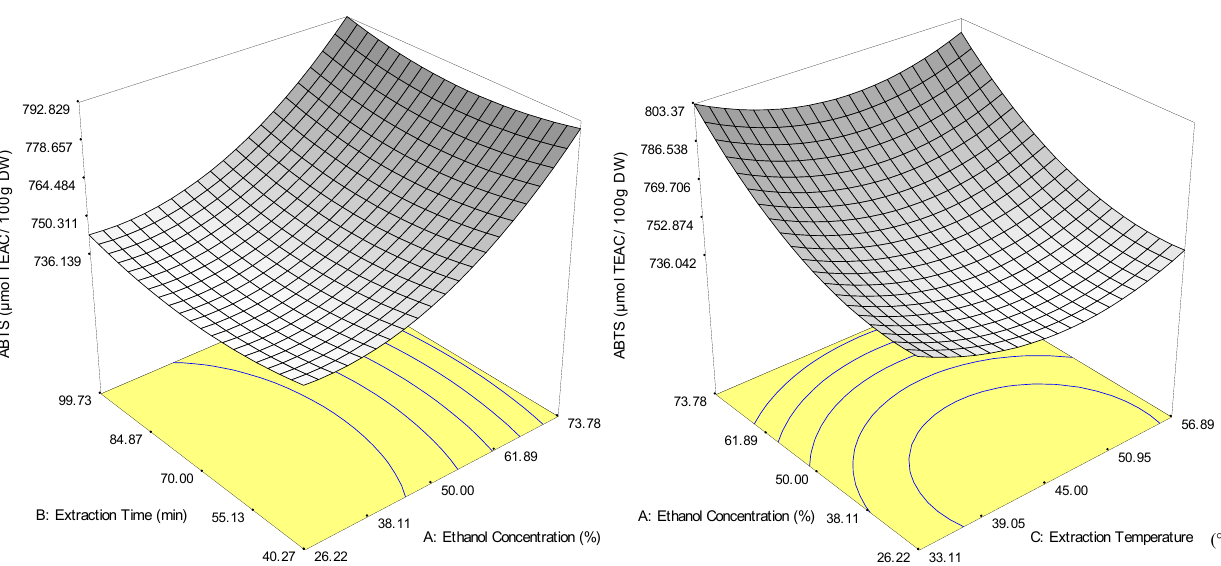
Figure 2. Response surface plot for the effects of extraction conditions on the recovery of ABTS of ethanol extracts from M. citrifolia powder by solvent